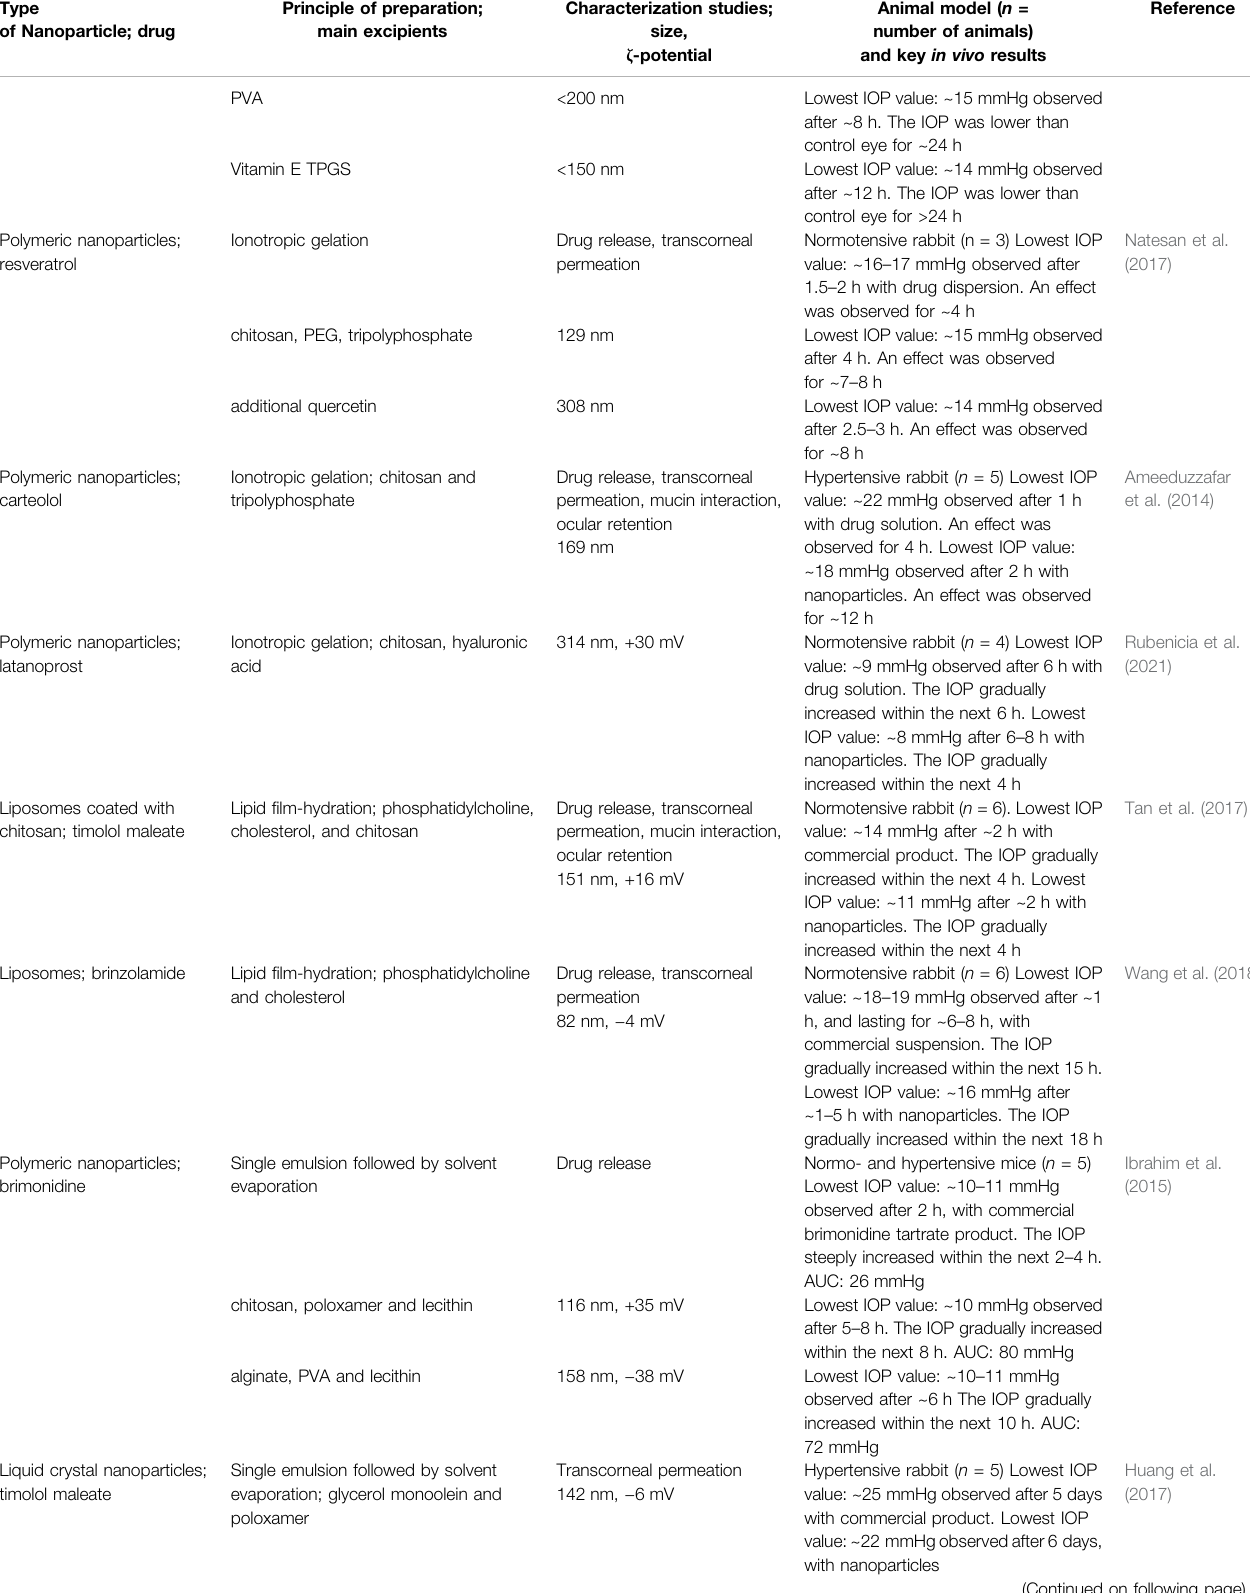
TABLE 4 | ( Continued ) Summary of in vivo studies on nanoparticle-based systems used for drug delivery to anterior segment of the